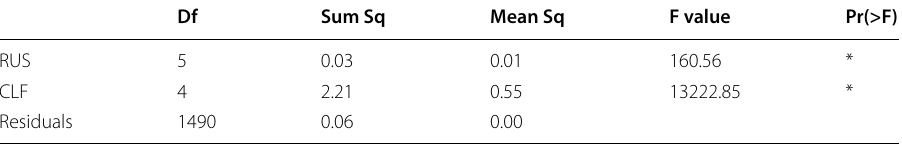
*Indicates the value is less than 1 × 10 − 4